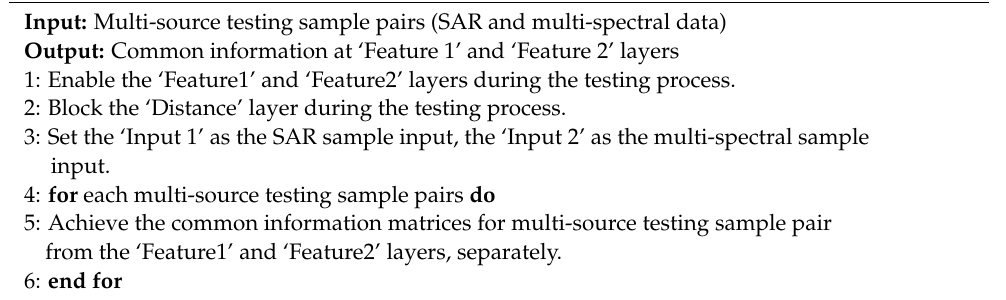
Algorithm 2. Testing process of the common information extraction